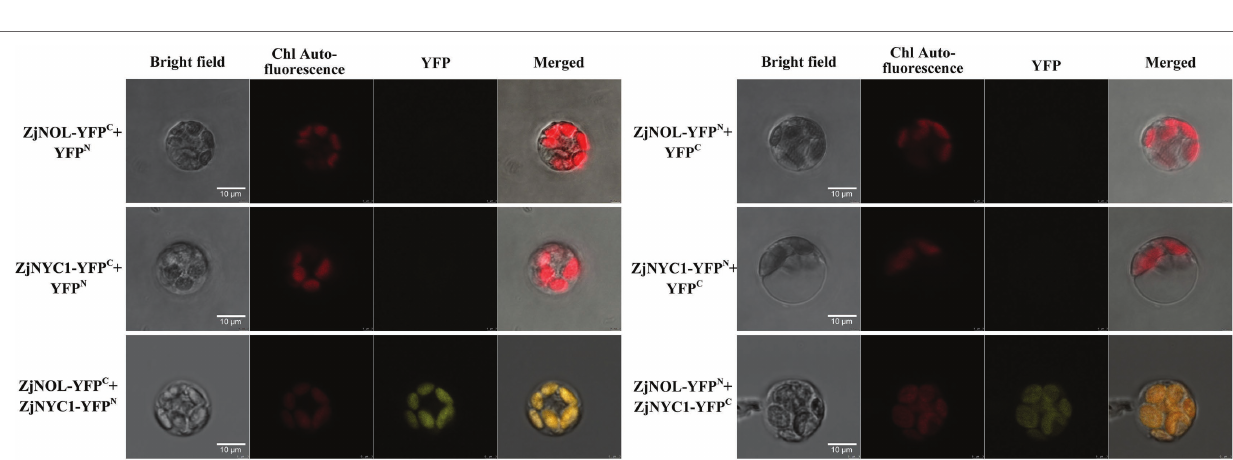
FIGURE 4 | Subcellular localization of ZjNOL in Zoysia japonica protoplast. The results showed that ZjNOL was localized in the chloroplast.